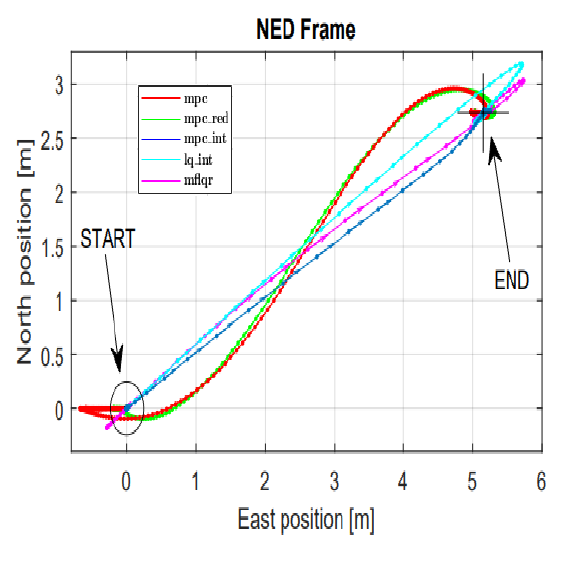
Figure 7: NED and Body coordinate